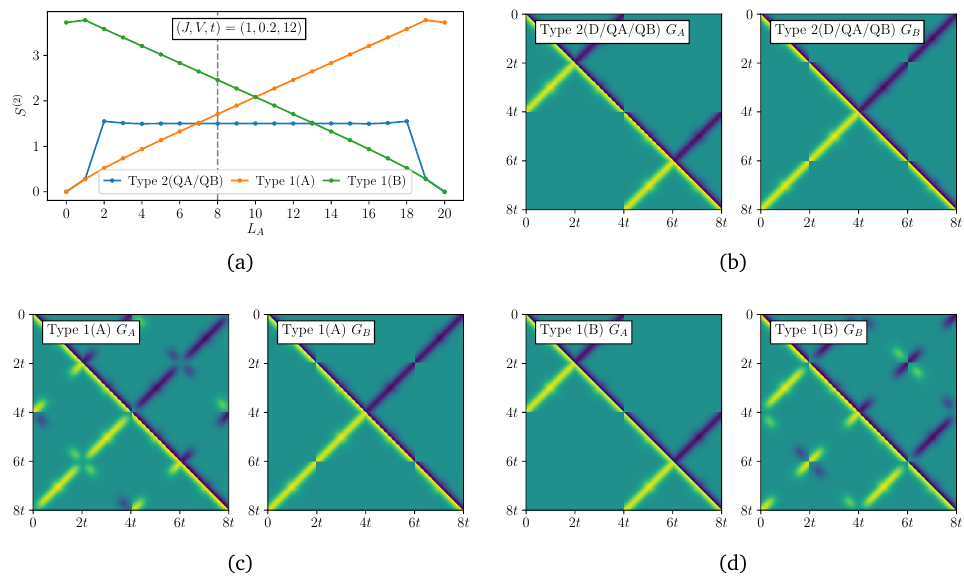
Figure 4: (a) Subsystem scaling of S ( 2 ) obtained from different saddle point solutions: Type 2(QA / QB) saddle, Type 1(A) saddle, and Type 1(B) saddle. (b)–(d) The Green’s function profile in the subsystem bulks corresponding to (b) the Type 2(D / QA / QB) saddles, (c) the Type 1(A) saddle, and (d) the Type 1(B)